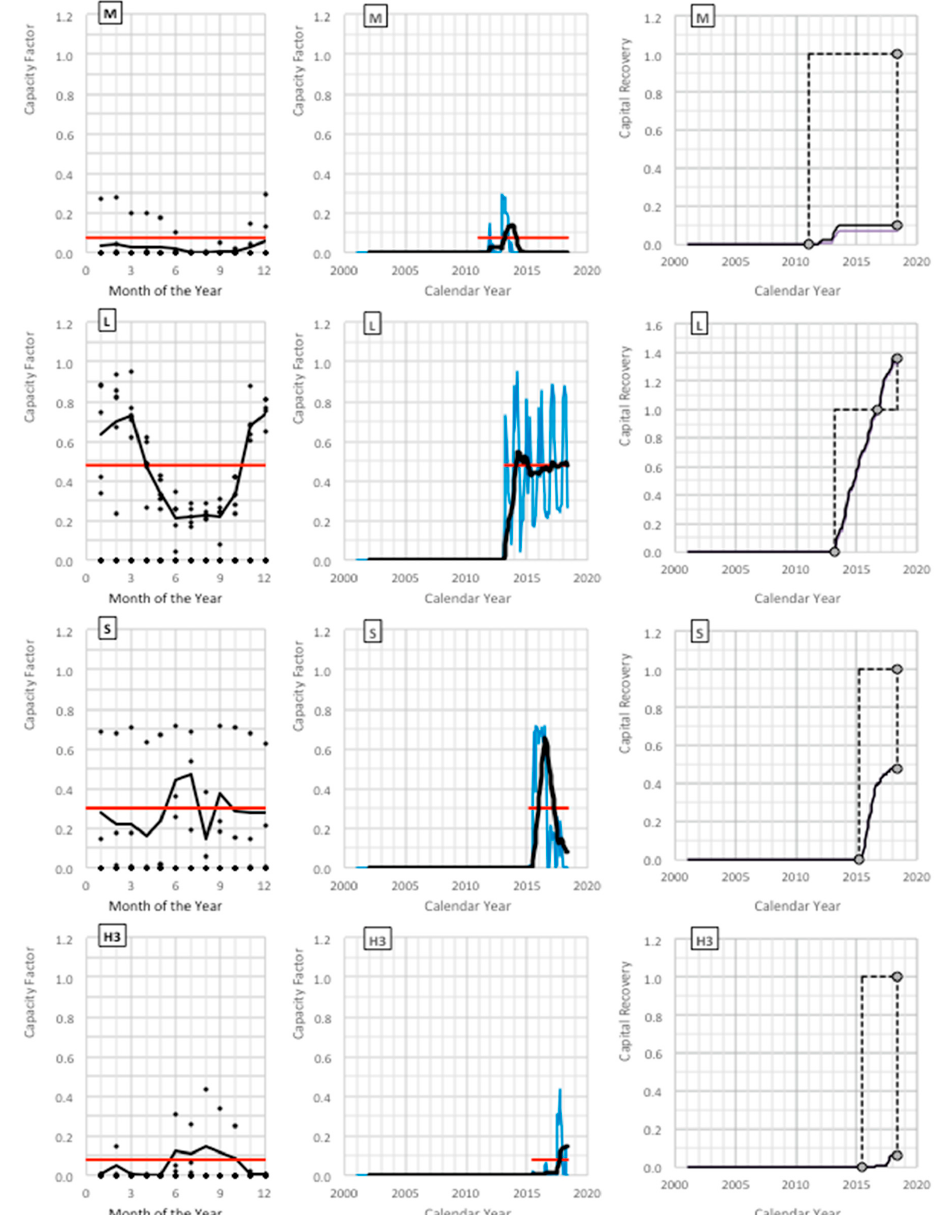
Figure 4. The evolution of the KPIs over the years in operation for the eight Athens CHP projects. ( a ) The first-column diagrams present the monthly capacity factor versus the calendar month, where the black solid line represents the monthly average and the red line the life average. ( b ) The second-column diagrams present the capacity factor versus the time in operation, where the black line represents the 12-month moving average and the red line the life average. ( c ) The third-column diagrams present the capital recovery versus the time in operation. The purple line shows the case of self-consumption and the black line the FiT supporting scheme. The highlighted dots represent the starting point of the capital recovery curve, the 𝐵𝐸𝑃 , and the total 𝐶𝑅 (cid:3021) at the end of the analysis period, for the case of FiT.